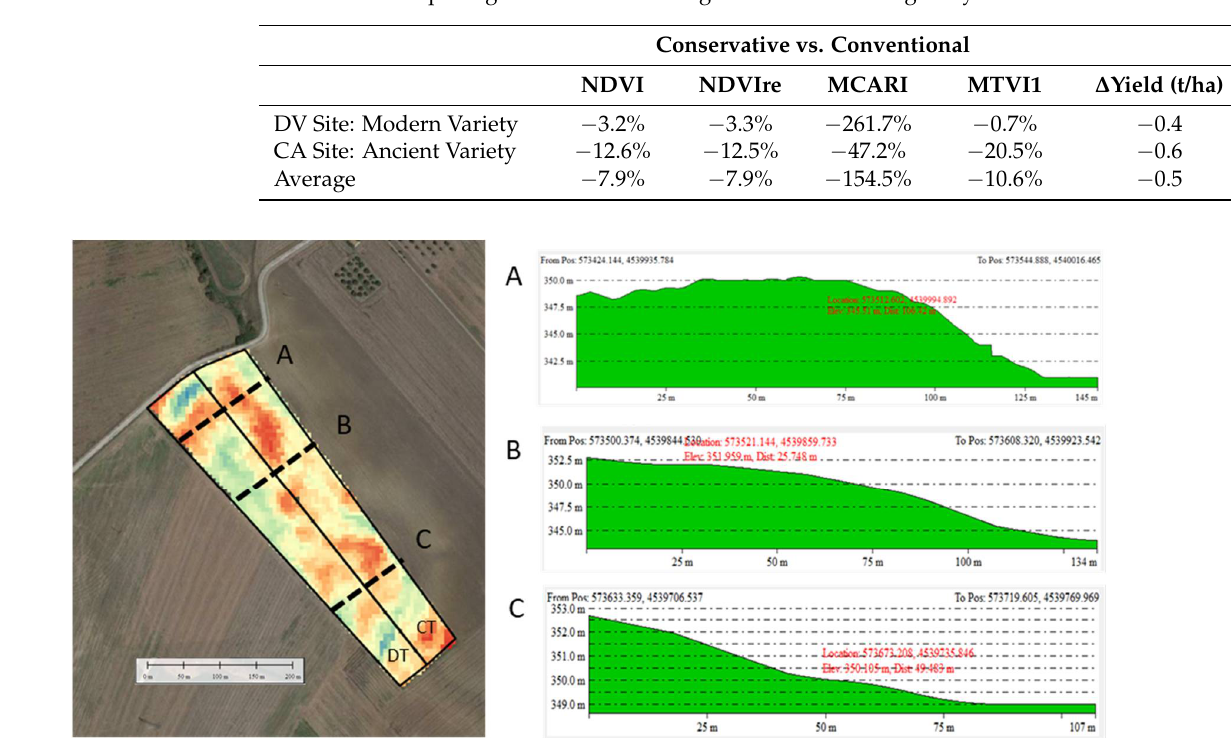
Table 4. Performance of conservative tillage management (no tillage and ripping) with respect to conventional deep tillage for the different vegetation indices and grain yields.